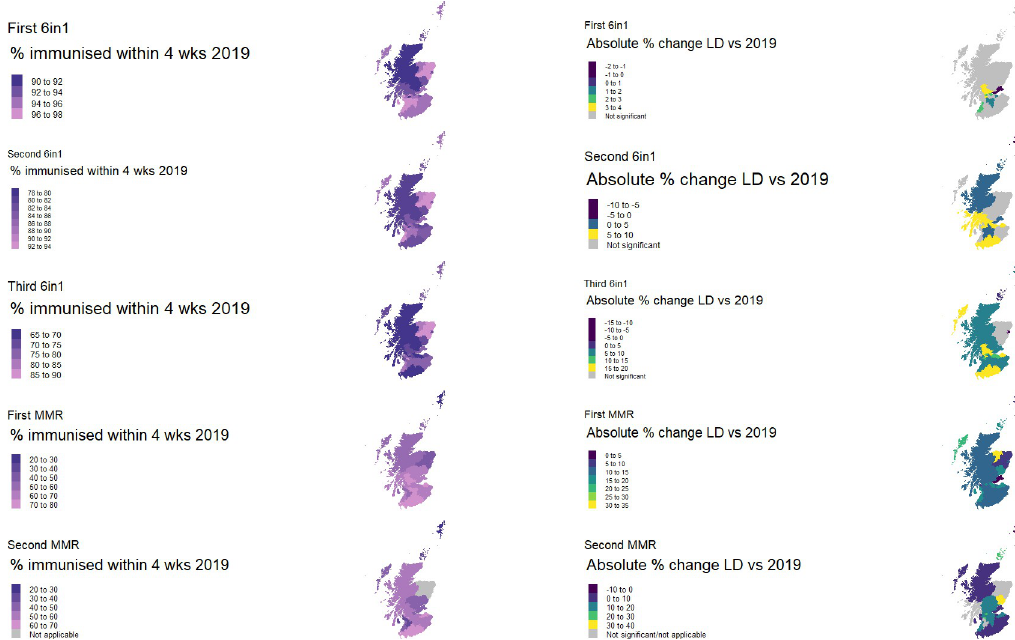
Fig 2. Percentage uptake by Scottish HSCP in 2019 and statistically significant increases between 2019 and “lockdown”. Left-hand side maps show baseline mean percentage uptake by HSCP in Scotland in 2019, and right-hand side maps show percentage point difference between 2019 and lockdown for areas in which the difference was statistically significant for each vaccine. Grey areas indicated HSCP where there were no statistically significant changes in uptake between 2019 and lockdown. Note that in Grampian, the second MMR dose is delivered at a later age; therefore, data for this area are recorded as “nonapplicable” (further details in S2 File). The full dataset can be found in S3 Table. Base layer map available from https:// spatialdata.gov.scot/geonetwork/srv/eng/catalog.search;jsessionid=714BD98E15D22A8116824CA25B30DC02#/metadata/ ac5e870f-8fc2-4c21-8b9c-3bd2311a583f, which contains public sector information licenced under the Open Government Licence v3.0. HSCP, Health and Social Care Partnership; LD, lockdown; MMR, measles, mumps, and rubella; Wks, weeks.